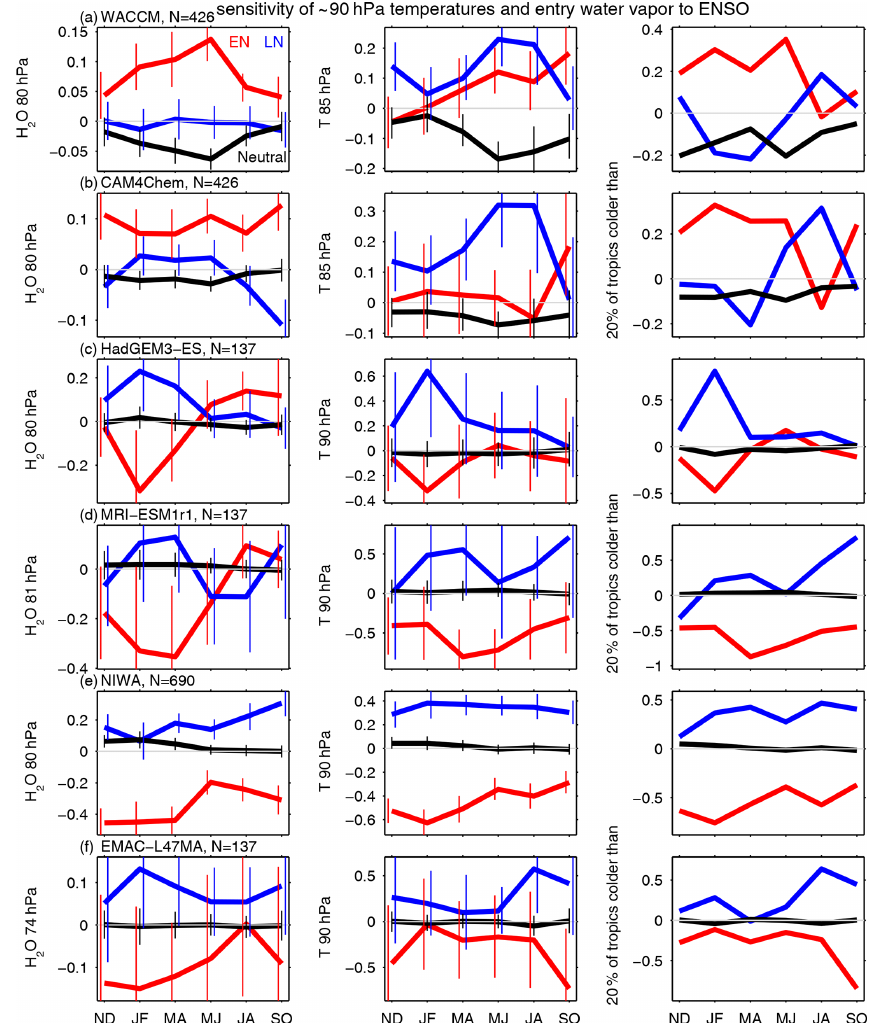
Figure 2. Tropical water vapor from 15 ◦ S to 15 ◦ N near 80hPa in each of the six CCMI models considered here from the late fall as the event is developing through to the following summer for (red) El Niño, (blue) La Niña and (black) neutral ENSO (left column). The 5% confidence intervals on the anomalous response based on a two-tailed Student’s t test are shown. The response of zonally averaged temperature anomalies from 15 ◦ S to 15 ◦ N near 90hPa for each model (middle column). The evolution of the temperature of the coldest 20% of the tropics at 90hPa for each model in each ENSO phase compared with the model’s climatology (right